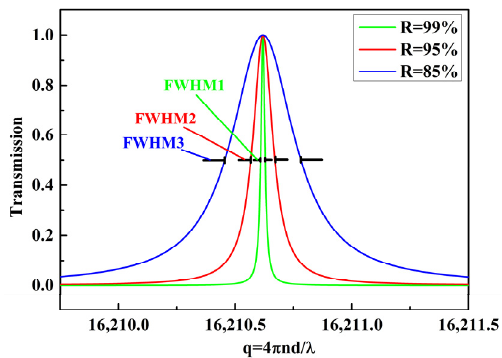
Figure 2. The transmission curves of the FPEs with mirror reflectivity of 99%, 95% and 85%. The FPE-based FOAS is an all-solid-state integrated FOAS, shown in Figure 3, which